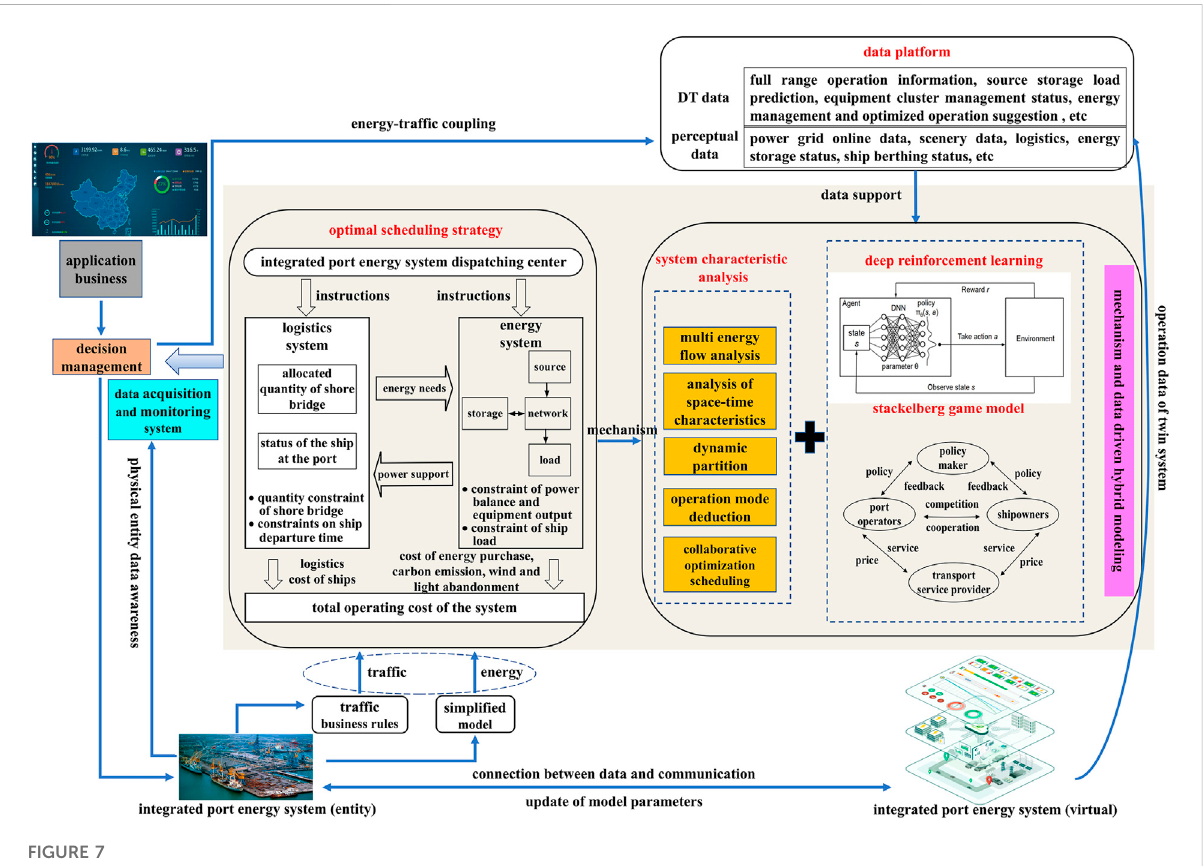
FIGURE 7 System optimization based on hybrid driving method of mechanism and